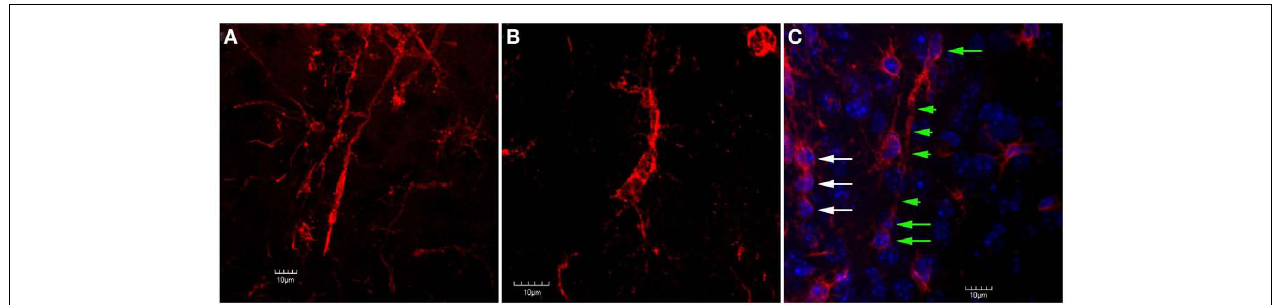
have their apical and basal processes connected. In (C) , Iba1-labeled cells are shown in tissue that has been counterstained using DAPI. Note that there are at least three rod-cells (green arrows) within this train that contain relatively long apical and basal processes (green arrowheads). Another train of cells that does not exhibit this rod shape (white arrows) is seen at the left edge of the image. Although these cells do not exhibit a rod shape, they still appear to be connected by their apical and basal processes. Scale bars in all images = 10 µ m.